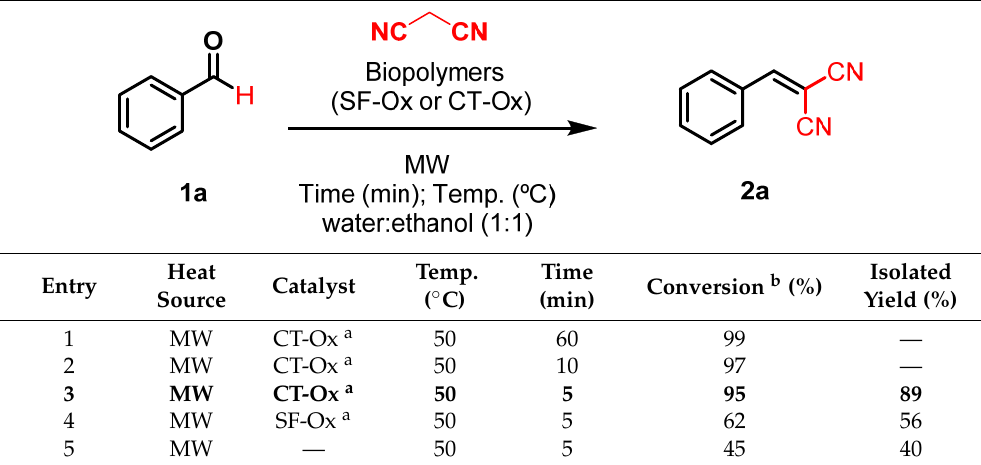
Table 1. Optimization process for the synthesis of Knoevenagel adduct 2a using CT-Ox or FS-Ox as a catalyst under MW irradiation as a heating source.